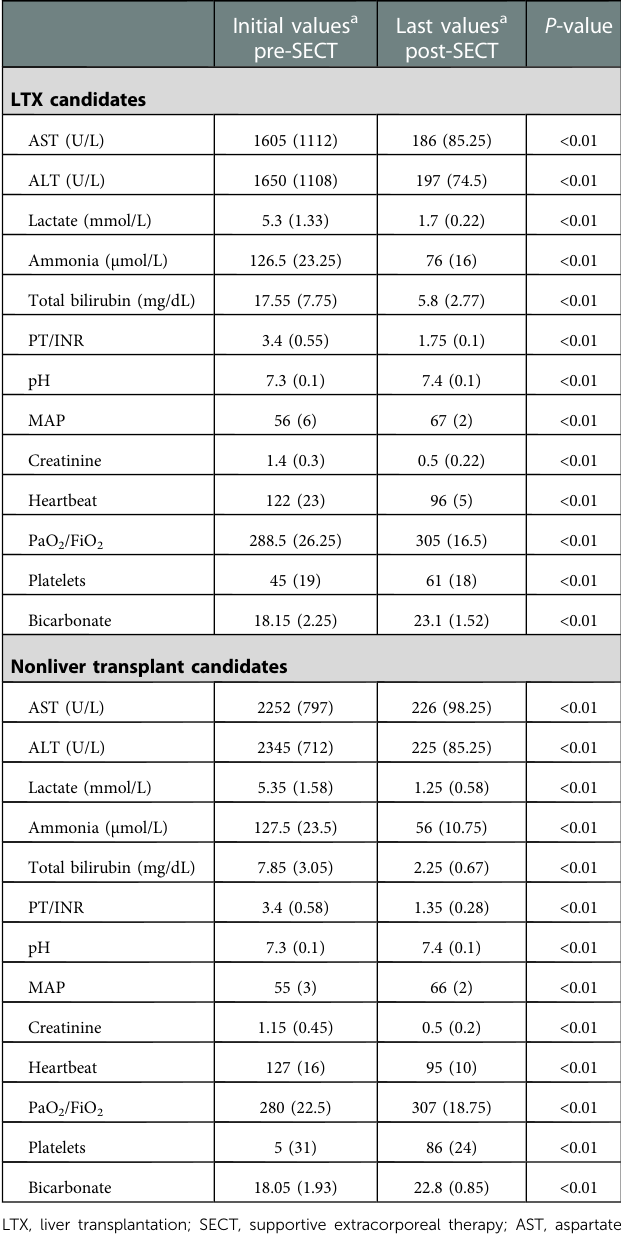
TABLE 4 LTX candidates (underwent liver TX after the last SECT) and nonliver transplant